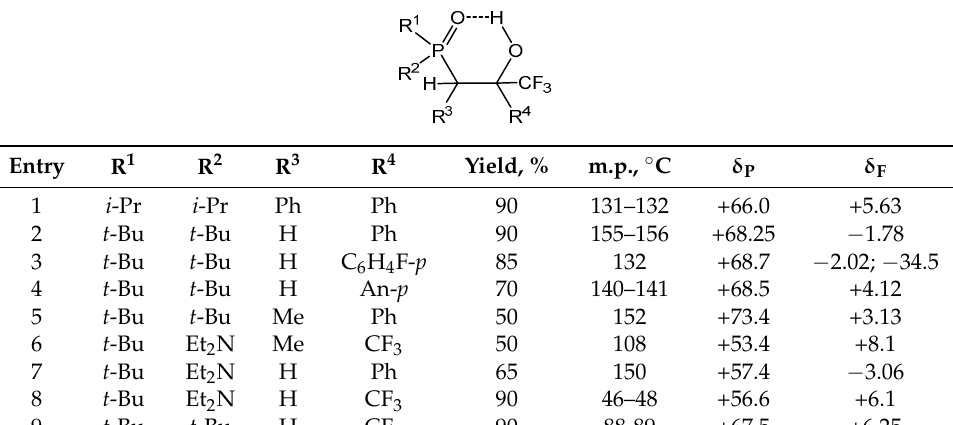
Table 5. 2-Hydroxyalkylphosphine oxides 23 (Scheme 23) [39,42].